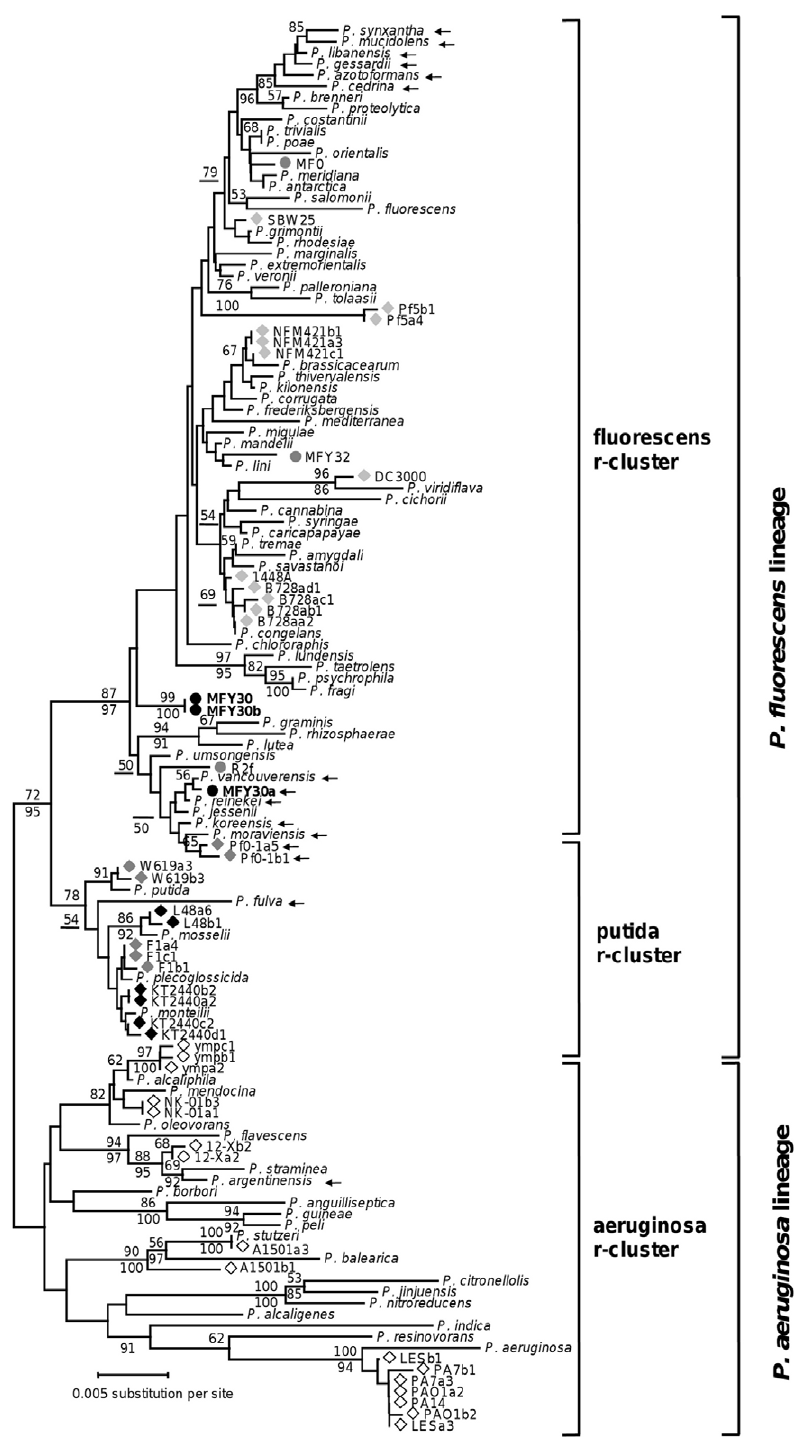
Figure 1. Phylogenetic relationships among 16S ribosomal RNA genes. Sequences from the four strains studied (highlighted by circles), the sequenced strains of Pseudomonas (highlighted by diamonds) and 79 Pseudomonas type strains were included. The colour of the symbol corresponds to the 16S rRNA copy number in the given strain: white for a strain with 4 copies, light grey for a strain with 5 copies, dark grey for a strain with 6 copies, and black for a strain with 7 copies. The different alleles in the sequenced strains are identified by a letter after the name of the strain, followed by the copy number of this corresponding allele. An arrow marks a sequence with the peculiar motif found in the minor allele a of the MFY30 strain. The unrooted dendrogram was estimated using the Neighbour-Joining algorithm from evolutionary distances computed according to the Jukes and Cantor correction. Numbers on tree branches report bootstrap results from Neighbour-Joining (above branch, 1000 replicates) and Maximum Likelihood (below branch, 100 replicates) analyses for those branches having $ 50% support.